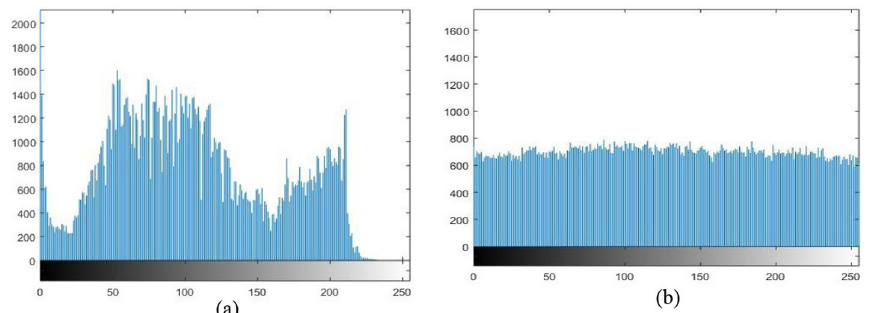
Fig. 6 a Histogram of original FRAME, ( b ) histogram of Encrypted frame